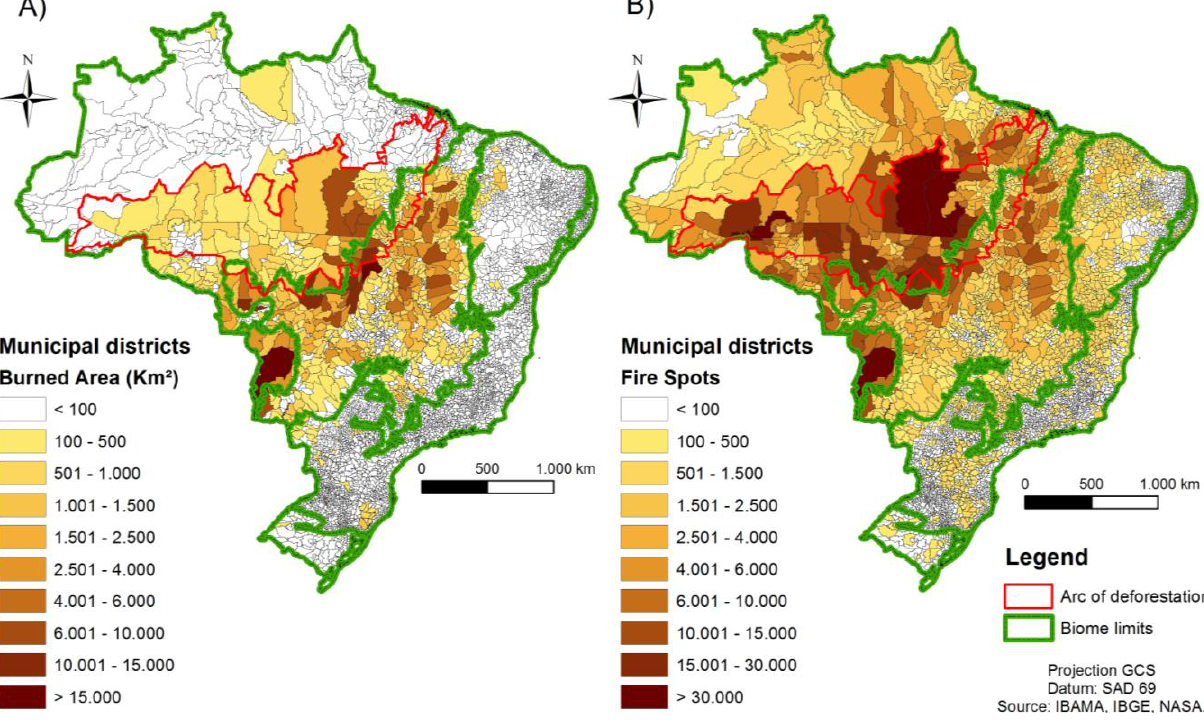
Figure 6. Distribution of El Niño and La Niña events between 2002 and 2010 (ENSO = El Niño Southern Oscillation). Source: NOAA